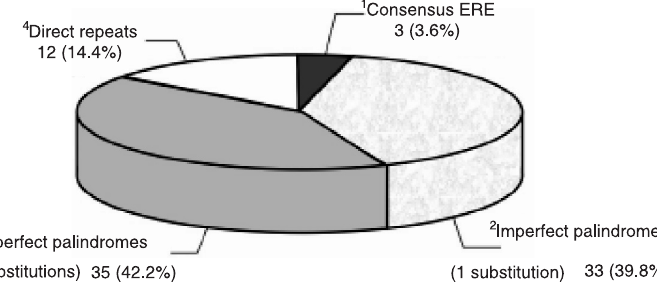
Figure 1. Summary of the results of the estrogen response element (ERE) search for 83 potential estrogen receptor target genes. The NCBI (http://www.ncbi.nlm. nih.gov) and USCU Genome Bioinformatics (http://www.genome.uscs.edu) data - bases were used to annotate the position of the 83 differentially expressed genes